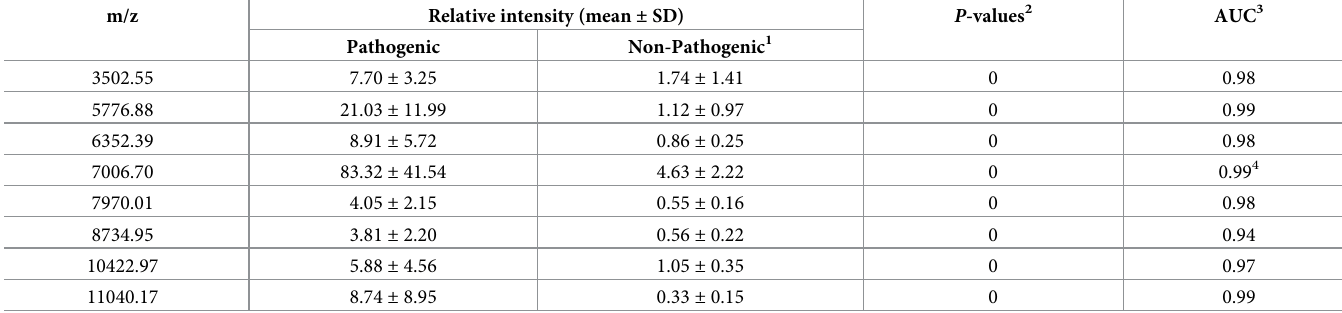
Table 5. Peak statistics of 8 discriminating peaks for pathogenic leptospires included in the GA model.